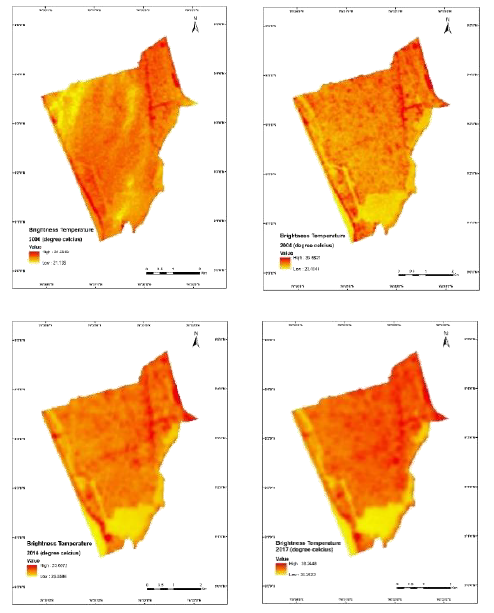
Figure 7 Brightness Temperature in the years 2000, 2004, 2014, and 2017 of the study